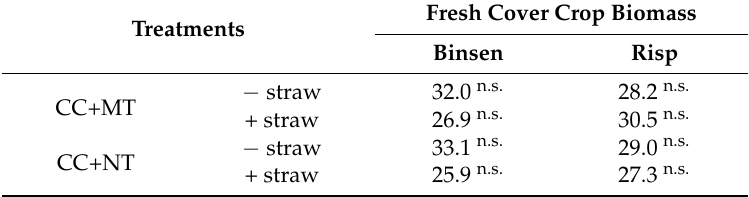
Table 5. The fresh cover crop biomass (t ha − 1 ) 8 (CC+NT) and 9 (CC+MT) weeks after sowing for the trials at the fields Binsen and Risp. CC+MT = cover crop mixture + mulch-till. CC+NT = cover crop mixture + no-till. − straw = straw removal after harvest. + straw = no straw removal from the previous crop. n.s. = means do not differ significantly within one experiment based on the Tukey–HSD test ( p ≤ 0.05). Fresh Cover Crop Biomass Treatments Binsen